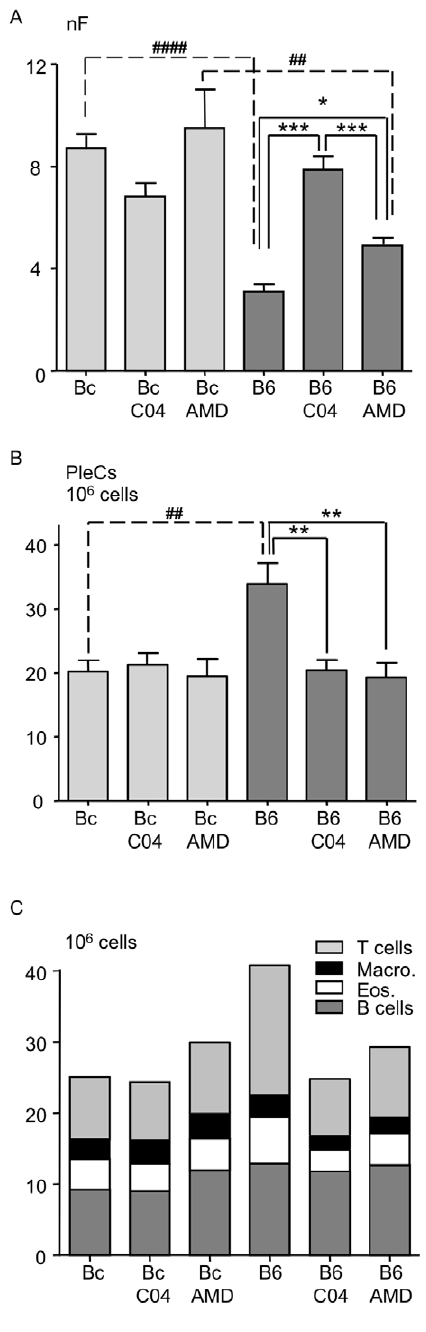
Figure 2. Reversal of resistance upon CXCL12/CXCR4 axis disruption. A. Filarial load 30 days post-inoculation in BALB/c mice (Bc, light gray) compared to C57BL/6 mice (B6, dark grey) after the disruption of the CXCL12/CXCR4 axis. Mice were treated with 100 m g AMD3100 (AMD) or 2.5 mg chalcone C04 (C04) at 10 and 20 days post- inoculation as described in Material and Methods. Results are